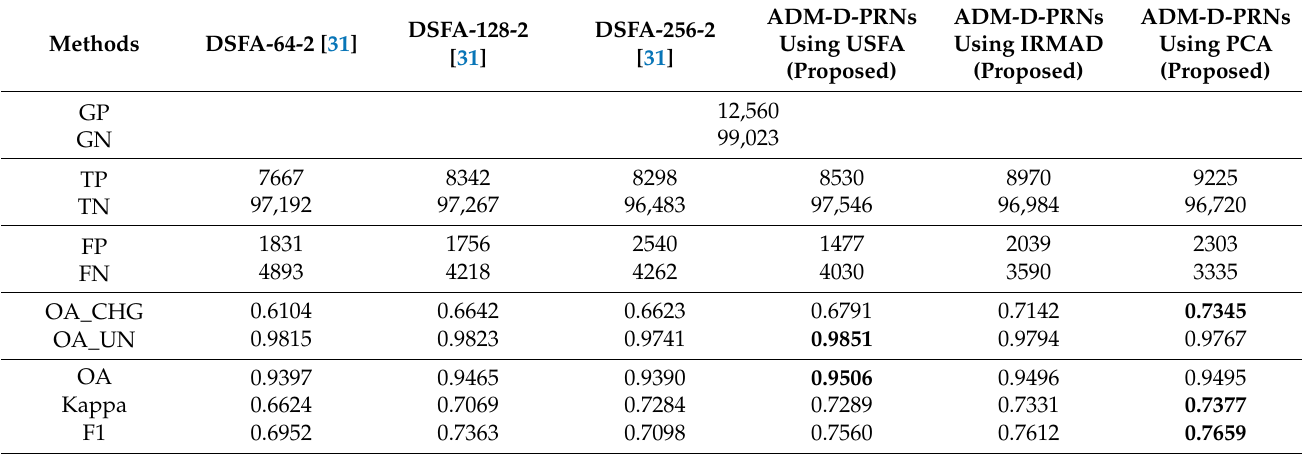
Table 2. Alteration detection results of dataset ‘River’ using Otsu.